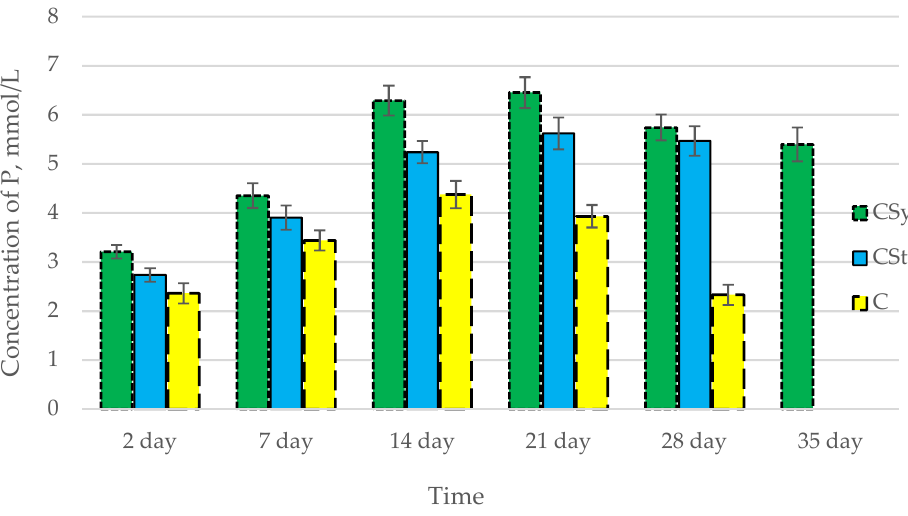
Figure 8. Phosphorus concentrations in the 2-, 7-, 14-, 21-, 28-, 35-day-old honey bees’ hemolymph after two methods of supplementation with hemp extract: C—control (pure sugar syrup), Csy—hemp extract in syrup, Cst—hemp extract on strips. (Two-Way ANOVA: supplementation method: F (2,146) = 166,54, p = 0.0000; days of supplementation: F (4,138) = 530,24, p = 0.0000; supplementation method × days of supplementation F (8,138) = 65,556, p = 0.0000.